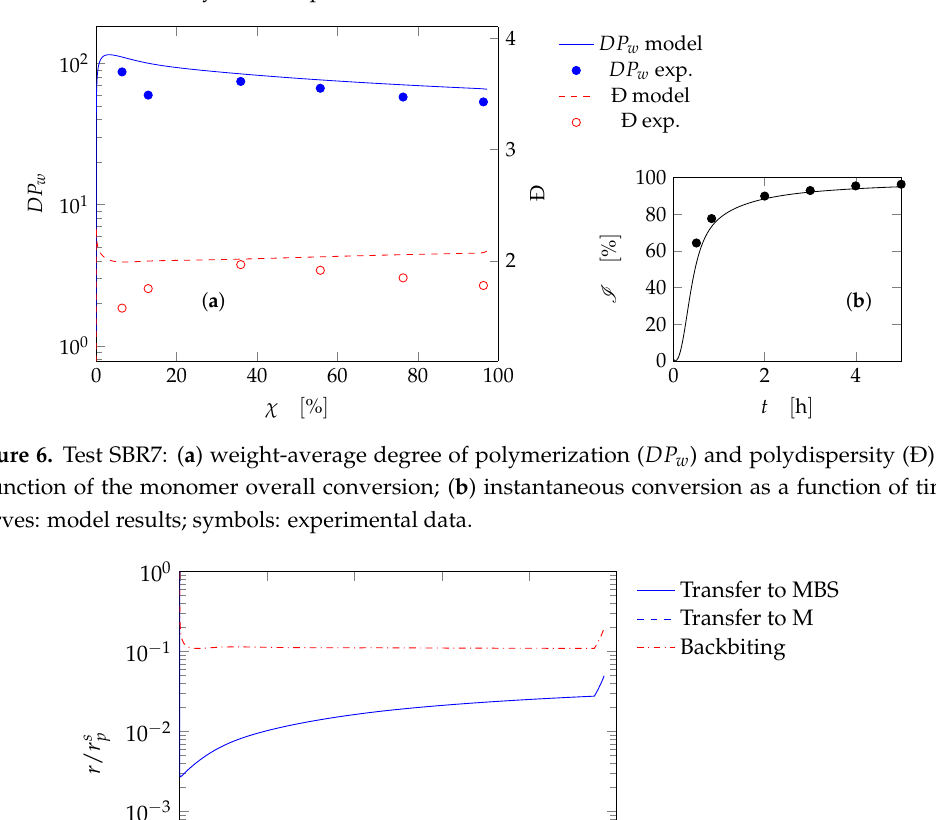
Figure 5. Test SBR6: ( a ) weight-average degree of polymerization ( DP w ) and polydispersity (Ð) as a function of the monomer overall conversion; ( b ) instantaneous conversion as a function of time. Curves: model results; symbols: experimental data.